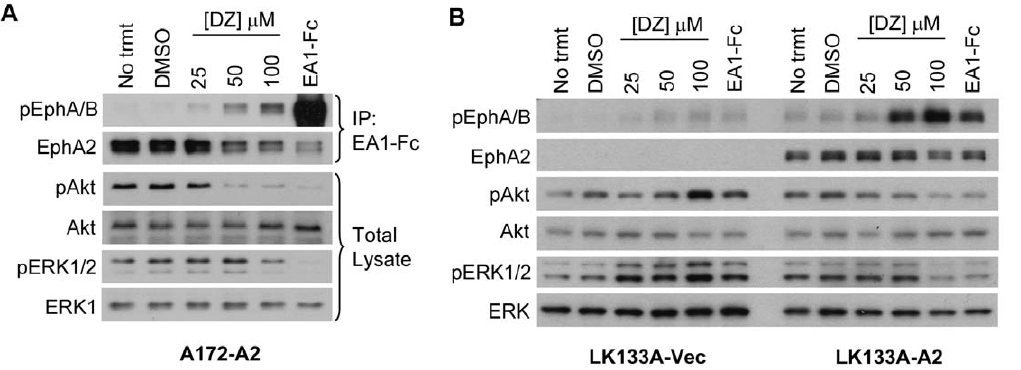
Figure 4. Doxazosin inhibits activation of ERK1/2 and Akt in an EphA2-dependent manner. (A) Immunoblot of lysates from A172-A2 cells treated with indicated doses of doxazosin (DZ) in 0.2% DMSO for 90 minutes. Treatment with 1 m g/ml ephrin-A1-Fc ligand for 10 minutes served as a positive control. Lysates were immunoprecipitated with ephrin-A1-Fc (IP: EA1-Fc) as given in Methods, and probed for pEphA/B and total EphA2. Total cell lysates were probed for phosphorylated forms of ERK1/2 and Akt, as well as total ERK1/2 and Akt. (B) Immunoblot of total cell lysates from LK133A-Vec and LK133A-A2 cells treated with indicated doses of doxazosin (DZ) in 0.2% DMSO for 90 minutes. Treatment with 1 m g/ml ephrin-A1-Fc for 10 minutes served as a positive control. Lysates were probed for phosphorylated forms of EphA/B, Akt, and ERK1/2, as well as total EphA2, Akt, and ERK1/2.